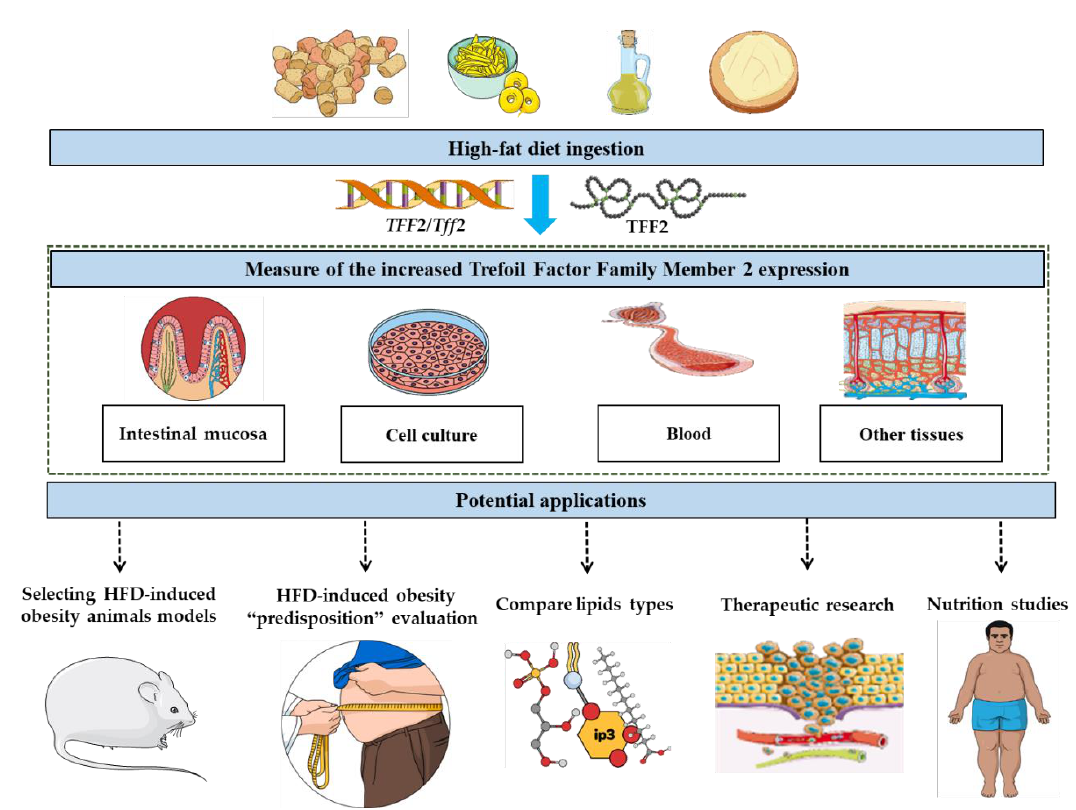
Figure 1. Measuring Trefoil Factor Family Member 2 (TFF2/ TFF2 / Tff2 ) expression in biological samples following the ingestion of high-fat diet reflects the biological “responsiveness” to the lipids ingestion and would reflect the severity of obesity establishment. Such property could be explored for instance to screen animal models, evaluate the predisposition to high-fat diet-induced obesity as well as in biomedical and clinical